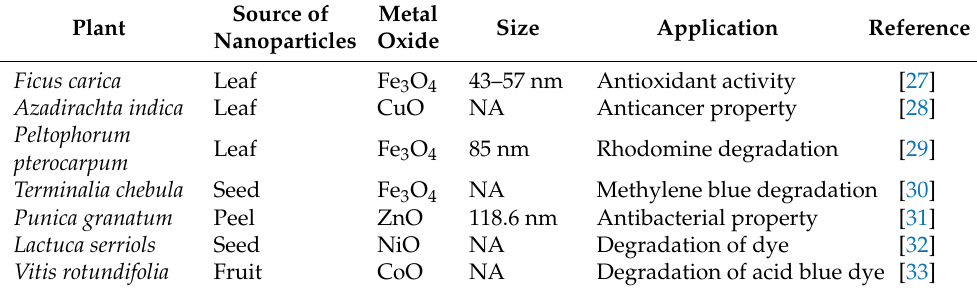
Table 2. Green synthesis of metal oxide nanoparticles using various plants, with applications. Source of Metal Size Plant Nanoparticles Oxide